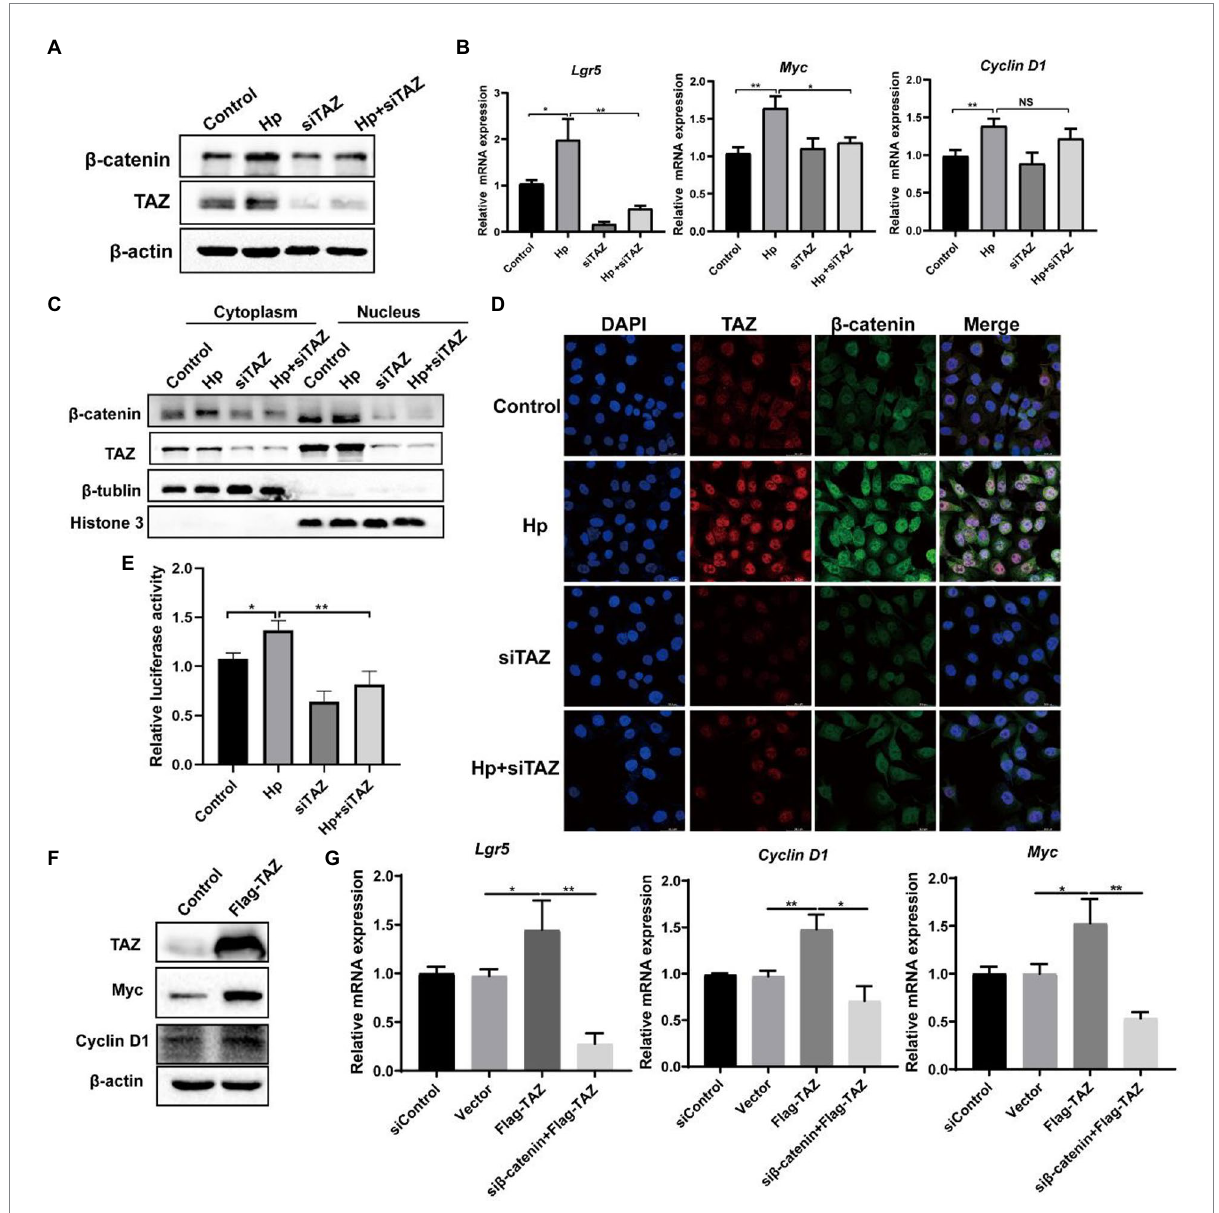
FIGURE 4 Helicobacter pylori infection promoted the β -catenin pathway via TAZ. (A) Western blot for total β -catenin and TAZ expression in gastric AGS cells transfected with TAZ siRNA and subsequently infected with H. pylori . (B) RT-PCR assay for mRNA levels of downstream genes of Wnt/ β -catenin pathway in the groups treated as described above. (C) After transfection with TAZ siRNA and infection with H. pylori , cytoplasmic and nuclear protein fractions were isolated. Western blotting was performed to determine the protein levels of TAZ and beta-catenin. β -Tubulin and histone H3 served as loading controls for cytoplasmic and nuclear proteins, respectively. (D) Immunofluorescence staining for TAZ and β -catenin cellular localization in the groups treated as described above. (E) TOP-Flash luciferase reporter assay for β -catenin transcriptional activity in AGS cells transfected with TAZ siRNA and infected with the H. pylori strain. (F) Western blot analysis of the protein levels Myc and Cyclin D1, which are downstream effectors of β -catenin, in AGS cells transiently transfected with Flag-TAZ or empty vector. (G) RT–PCR analysis of the mRNA levels of downstream effectors of β -catenin, such as Lgr5, Cyclin D1 and Myc, in AGS cells transfected with Flag-TAZ alone or in combination with β -catenin siRNA. H. pylori strains in all experiments were used at an MOI of 100. *p < 0.05, **p <